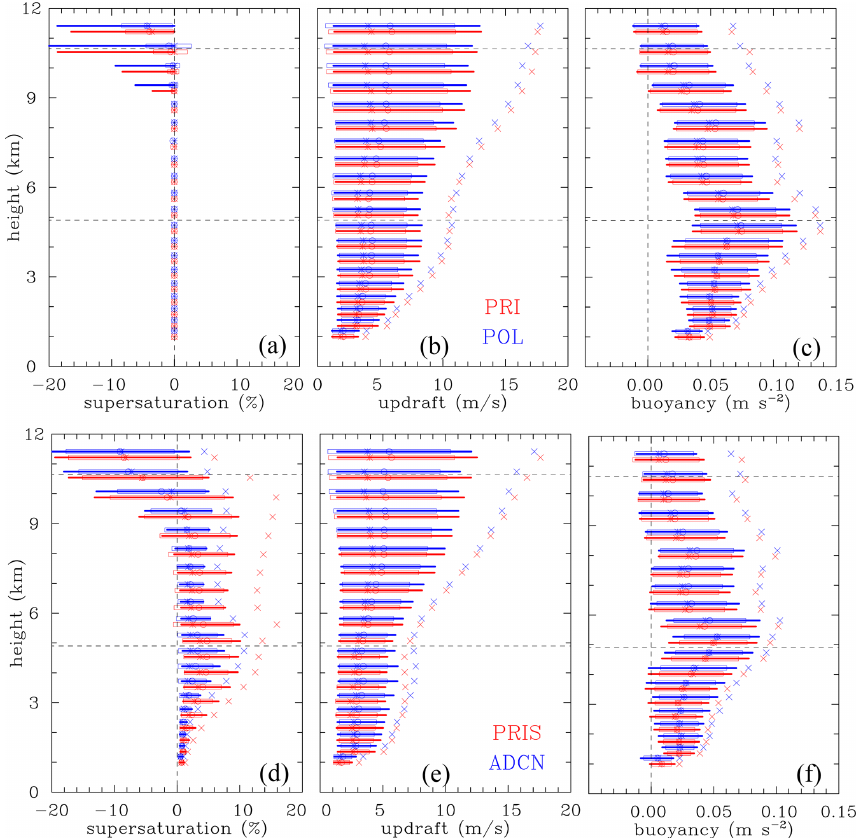
Figure 7. Statistics of (a, d) supersaturation, (b, e) vertical velocity, and (c, f) buoyancy in grid volumes with updraft larger than 1ms − 1 and total condensate larger than 1gkg − 1 . (a–c) Data for all ensemble members for the 6th and 7th hours of the simulations from PRI (red color) and POL (blue color) IAB ensembles. (d–f) Data for all ensemble members for PRIS (red color) and ADCN (blue color) for 2MOM ensembles. The star/circle symbols are for median/mean values, horizontal lines show the 10th to 90th percentile range, and the boxes show the range between the mean and plus and minus 1 standard deviation. The × symbols to the right of color lines and boxes are means of the data from the range between the 90th percentile and the maximum. The data are only shown every second model level with color lines and symbols shifted above (for ADCN) and below (for PRIS) that level. Dashed horizontal lines show approximate height of the 0 and − 40 ◦ C level. Dashed vertical lines in (a) and (c) show zero